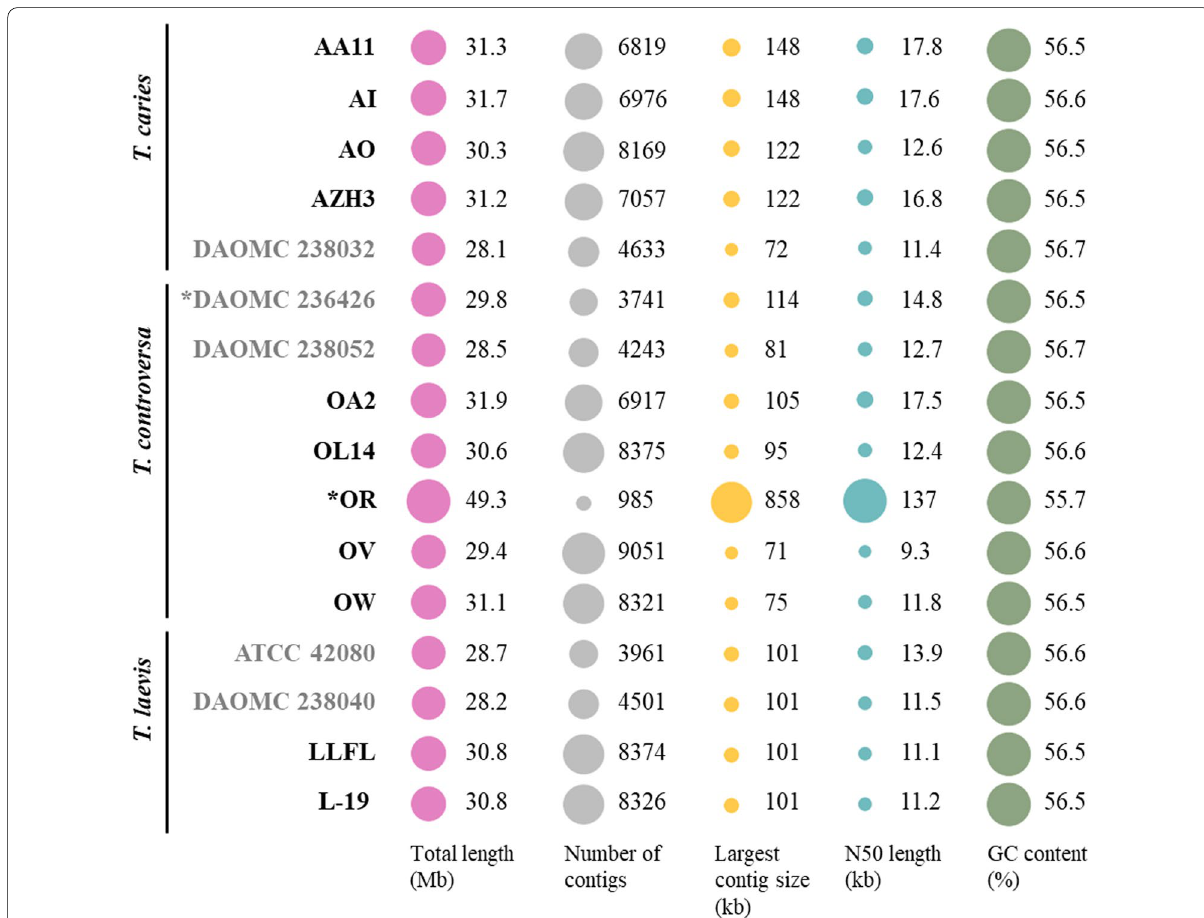
Fig. 1 Bubble plots of descriptive numbers for each genome. The bubble sizes are scaled only within categories. The genome assemblies done in this work are presented in black font. Those in grey font relate to genomes published by Nguyen et al. (2019). Two T. controversa isolates OR and DAOMC 236426 were sequenced both on Illumina and PacBio platforms and marked with